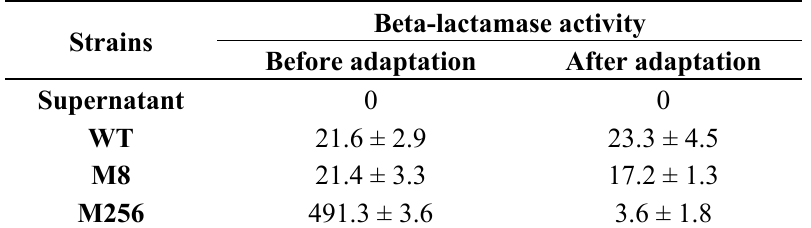
Table 2. Specific activities of the beta-lactamase of the WT, M8 and M256 strains (see Figure 1), before and after adaptation to cefotaxime (see Figure 5). The results are presented as the means and standard deviations of three biological duplicates. For each biological replicate, two independent measurements were